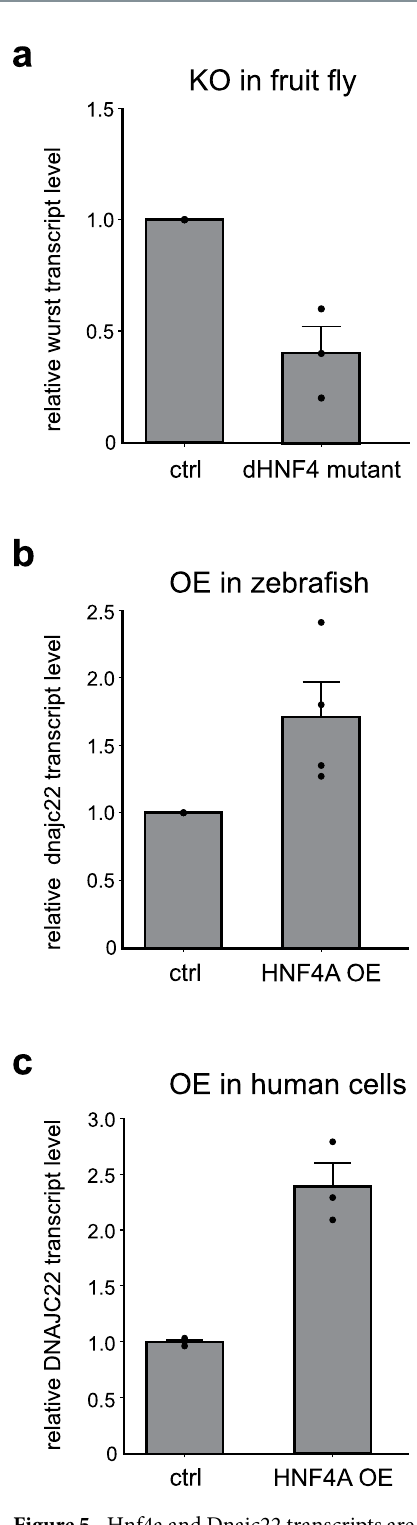
Figure 5. Hnf4a and Dnajc22 transcripts are co-regulated in fruitfly, zebrafish, and human. Endogenous expression of Dnajc22 ortholog transcript levels were analysed by quantitative realtime PCR in Hnf4a gain- and loss-of-function experiments. The data was generated from three independent experiments and normalized to the controls. Significance was tested using a one-sided paired t-test. ( a ) Drosophila melanogaster Dnajc22 ortholog wurst expression in Hnf4 mutant and control larvae. ( b ) Heterologous expression of human HNF4A in zebrafish embryos leads to elevation of zebrafish dnajc22 transcript levels. ( c ) Overexpression of human HNF4A in HEK293 cells leads to increased human DNAJC22 transcript